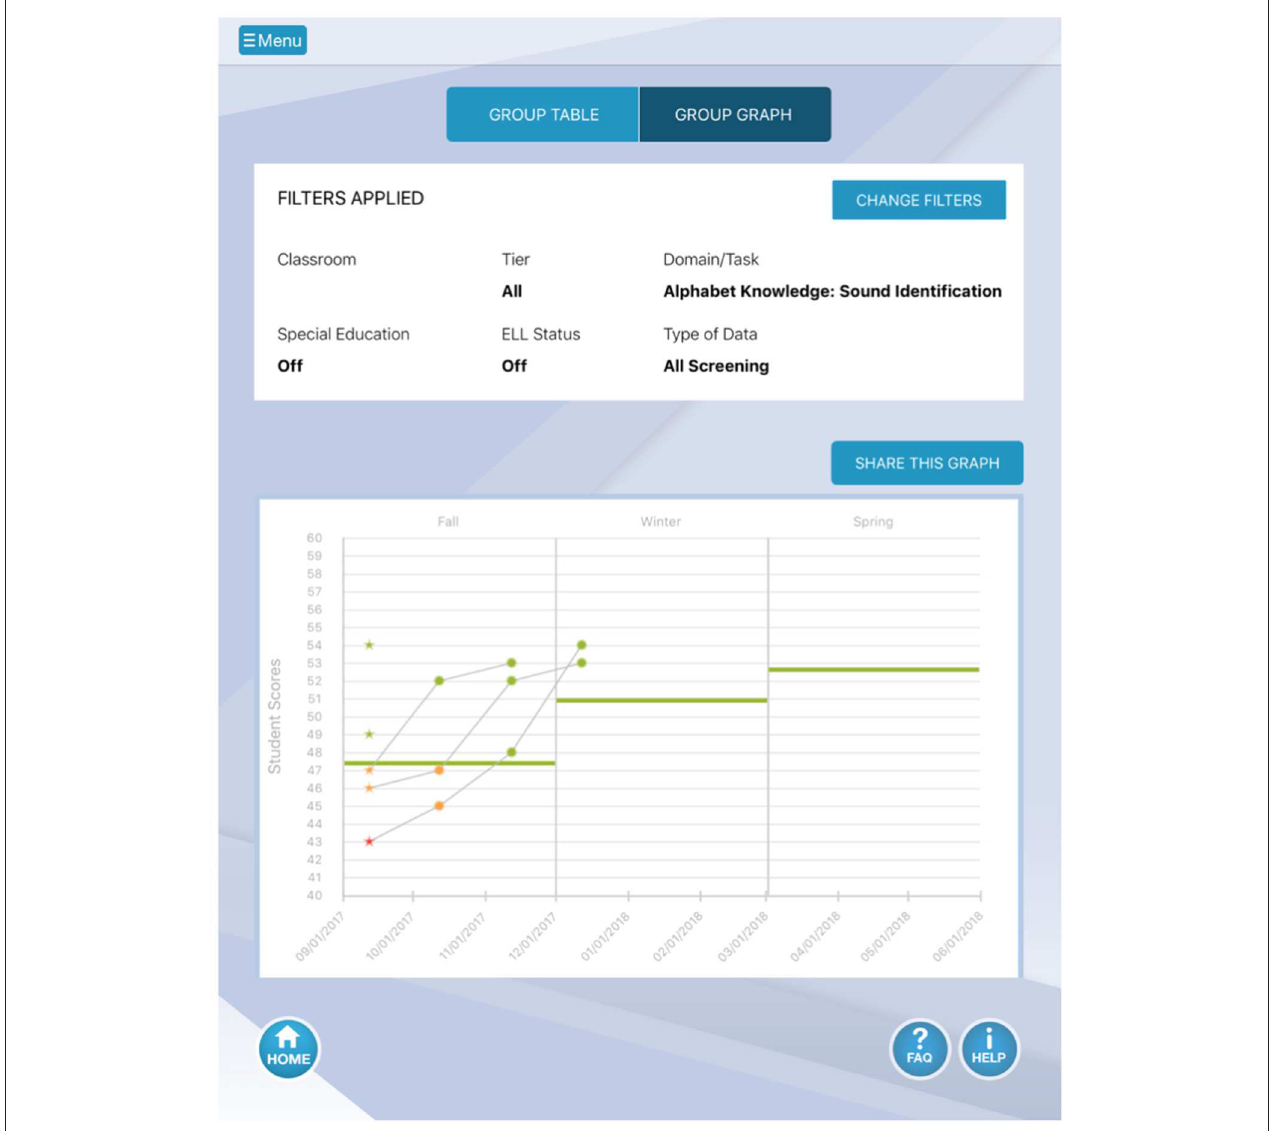
FIGURE 2 | Screenshot of a group classroom graph for one measure—Sound Identification. Stars indicate seasonal screening points and circles indicate progress monitoring points. The colors associate with MTSS tiers- green for Tier 1, yellow for Tier 2, and red for Tier 3. The group classroom graph is one of the resources available to educators in the app in addition to individual graphs, group tables and videos on psychometric